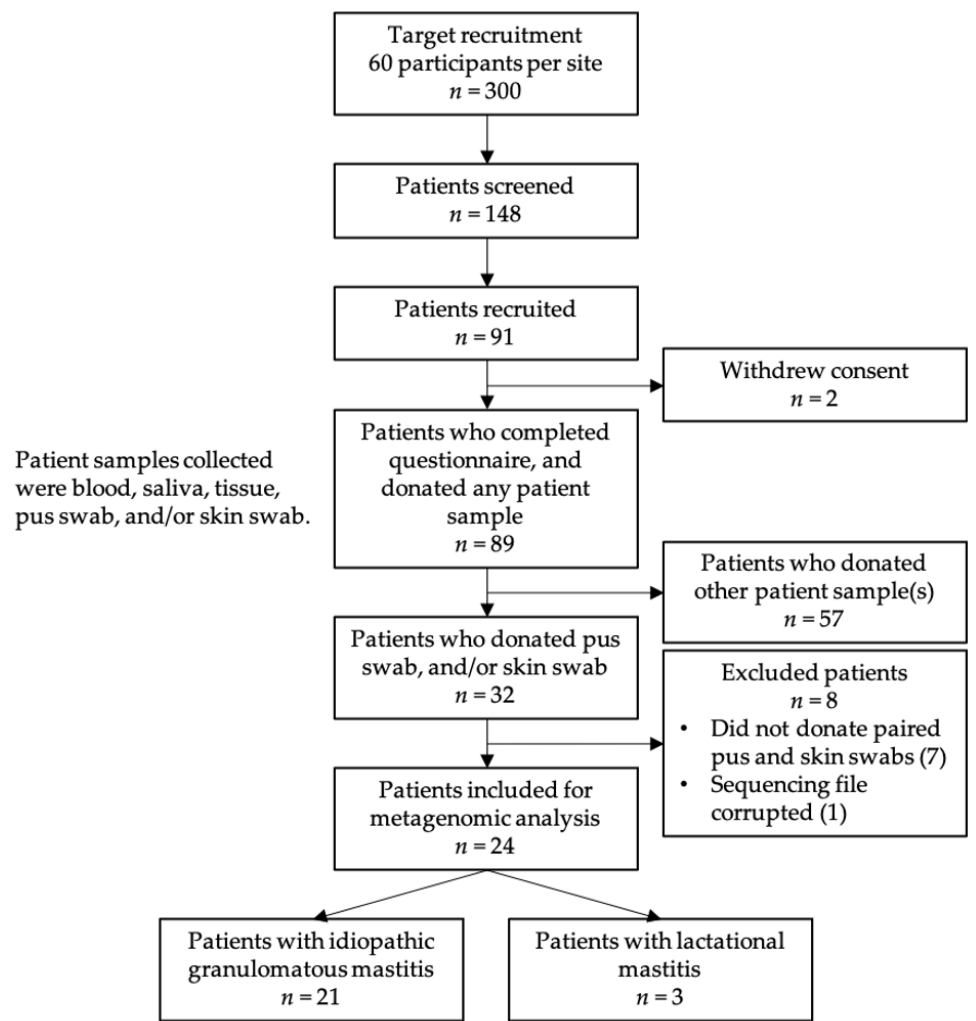
Figure 4. Patient recruitment, inclusion and exclusion flowchart.